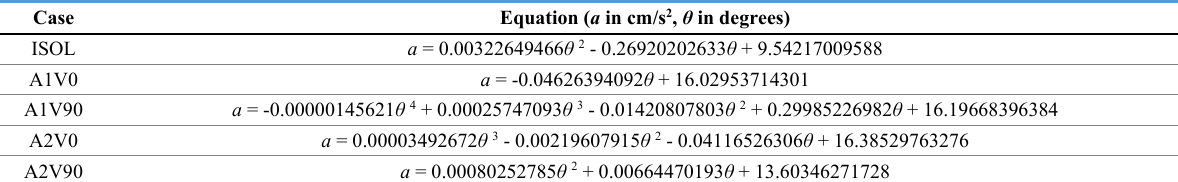
Table 1. Equations for maximum acceleration at the top, x-direction.